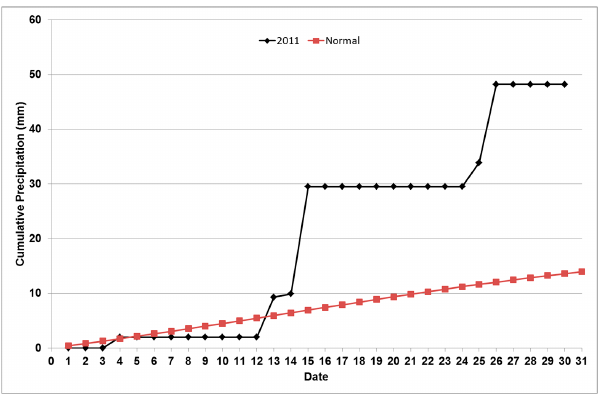
Figure 7. Cumulative precipitation plot for WMO station 41024 in Jeddah.